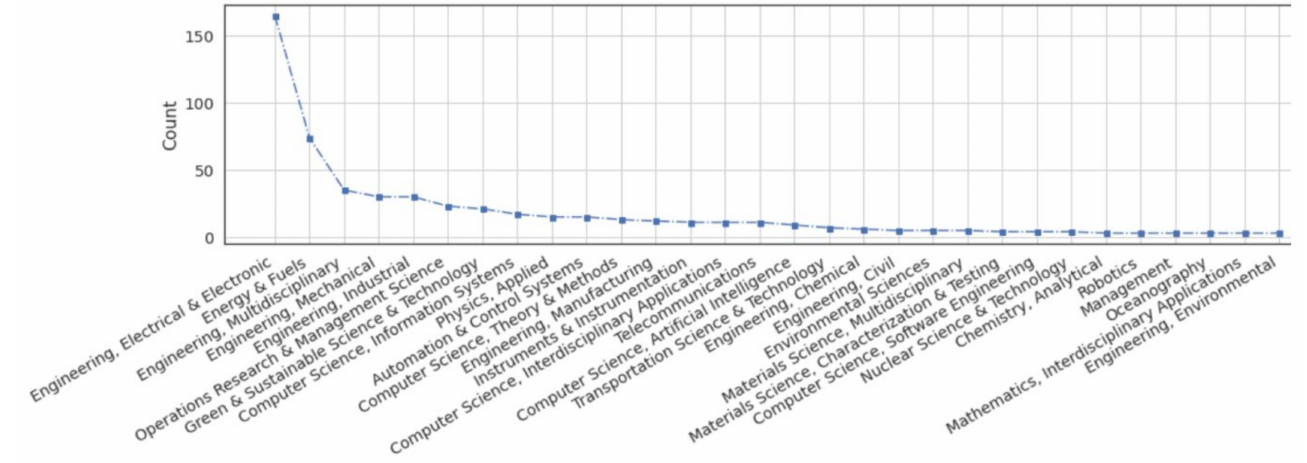
Figure 5. Top 30 most frequent categories in WoS